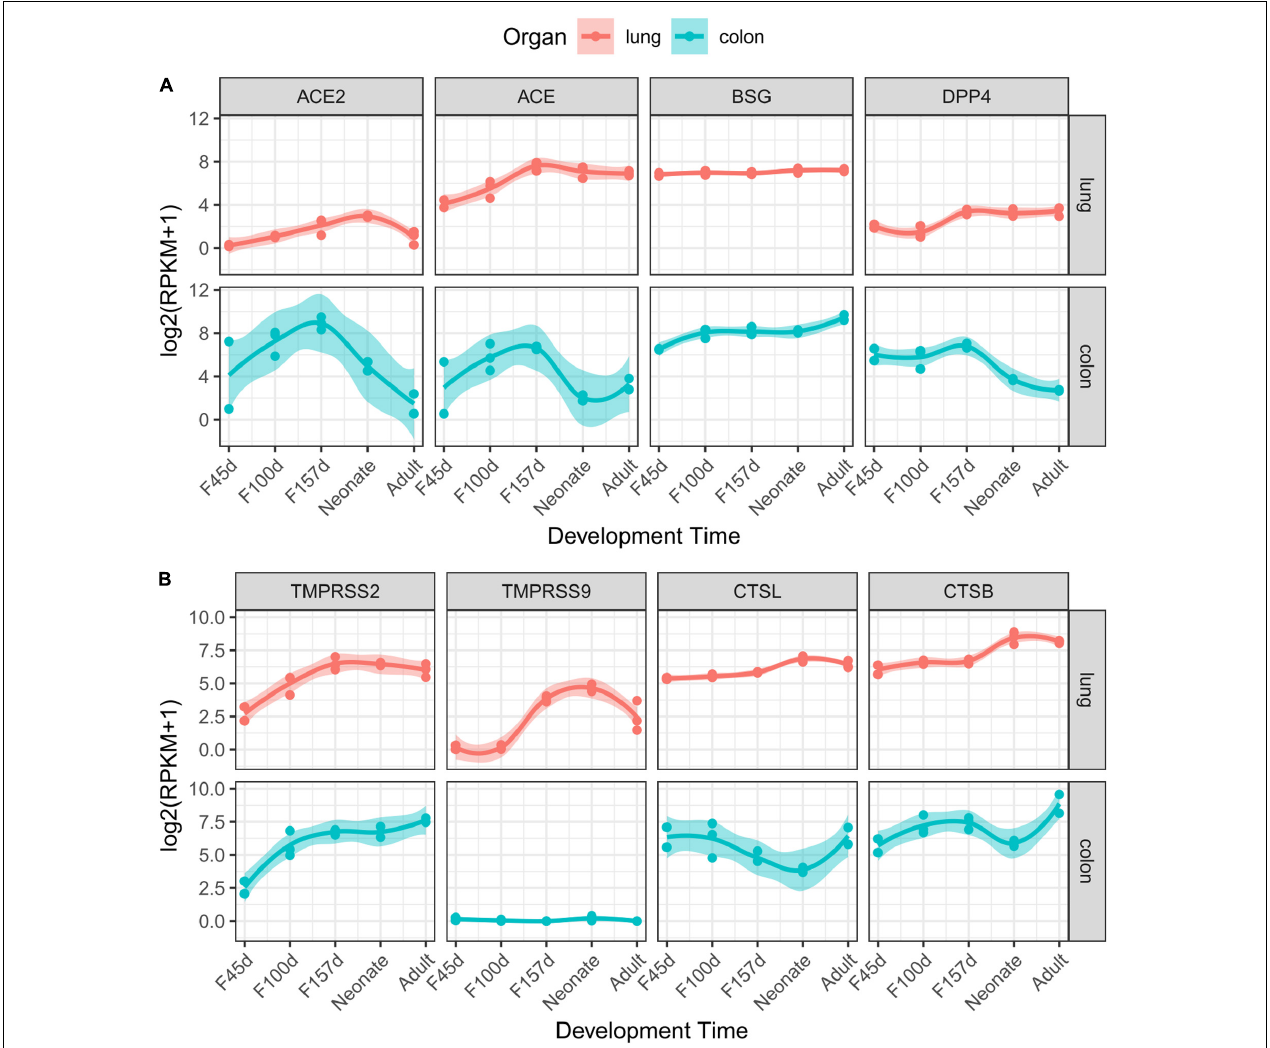
FIGURE 2 | Dynamic expression of eight genes during lung and colon development. Gene expression value of receptors (A) and proteases (B) along with developmental times are presented for the lungs (red) or colon (cyan). The trend curves were fitted by using LOESS method, with standard errors, as shown by